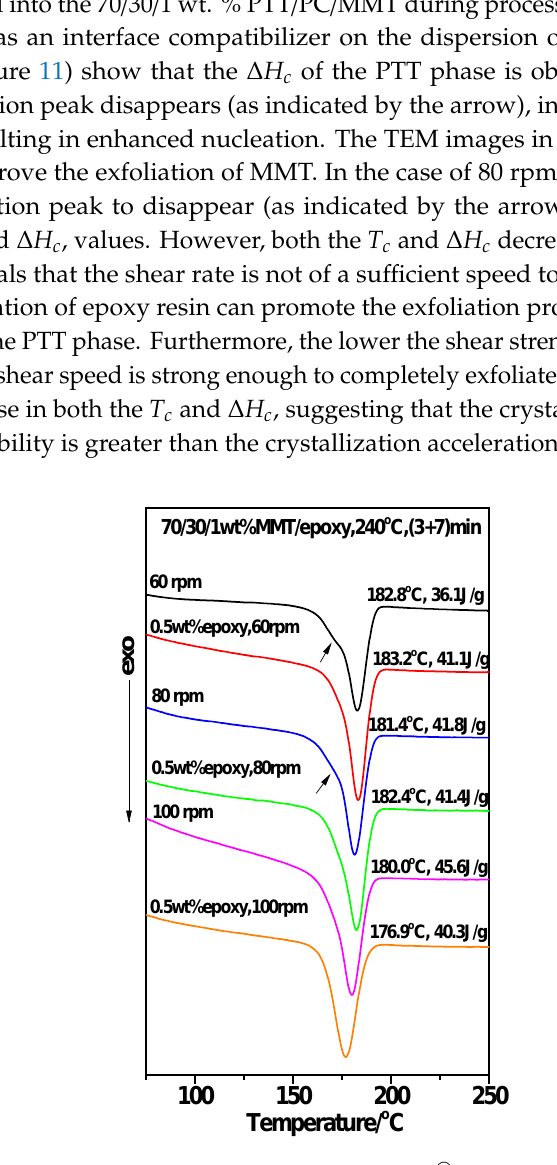
Figure 11. Effects of epoxy on the acceleration of MMT (Cloisite ® 25A) on the crystallization the 70/30 PTT/PC blends processed at indicated temperatures and shears.